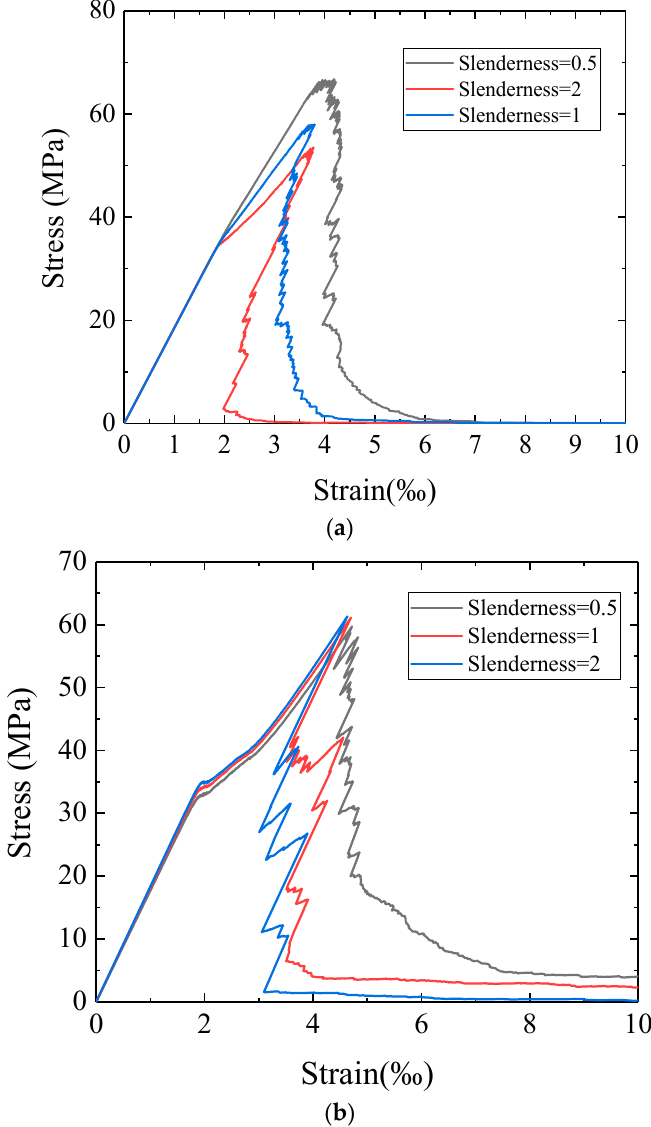
Figure 6. ( a ) Stress-strain curve for high friction boundary condition, ( b ) stress-strain curve for low friction boundary condition.